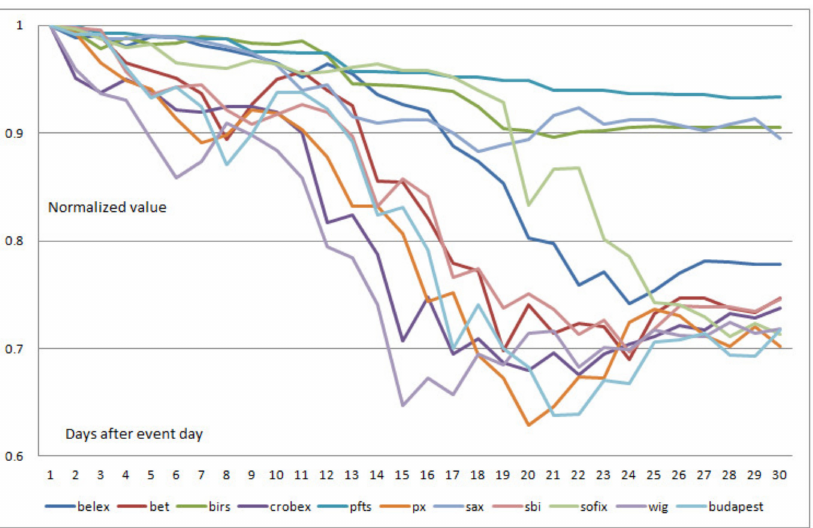
Figure 1. Normalized values of indices, peak day and one month later. Note: Peak day value normalized such that value of index is equal to 1, days of decline after the peak day, 30 days. Peak day is defined as the highest value of the stock market index, after which the decline of the value continued for more than two